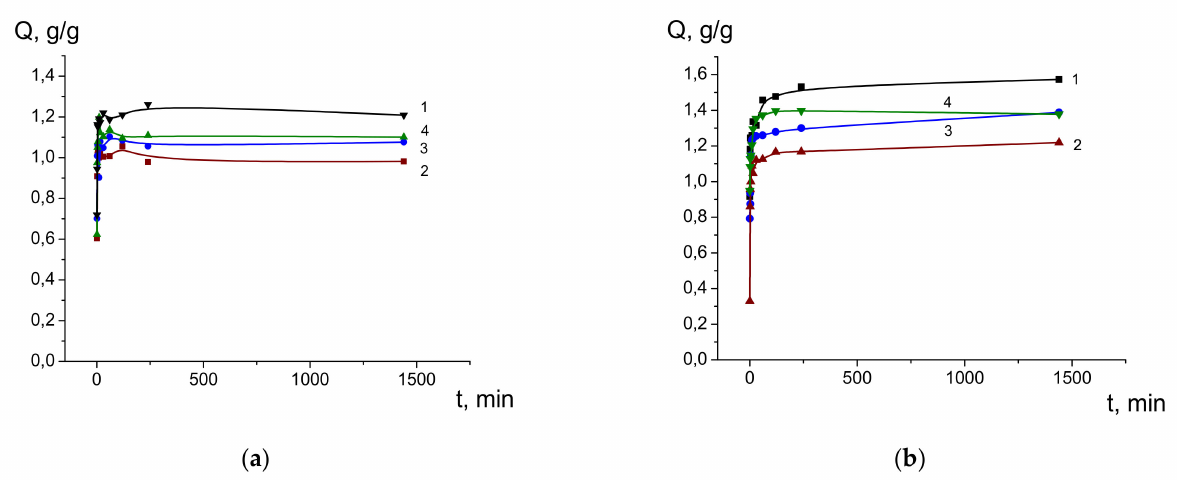
Figure 6. The swelling of films in water ( a ) and in a culture medium ( b ): 1—chitosan; 2—the composite containing 10% of lignin; 3—the composite containing 20% of lignin; 4—the composite containing 30% of lignin.